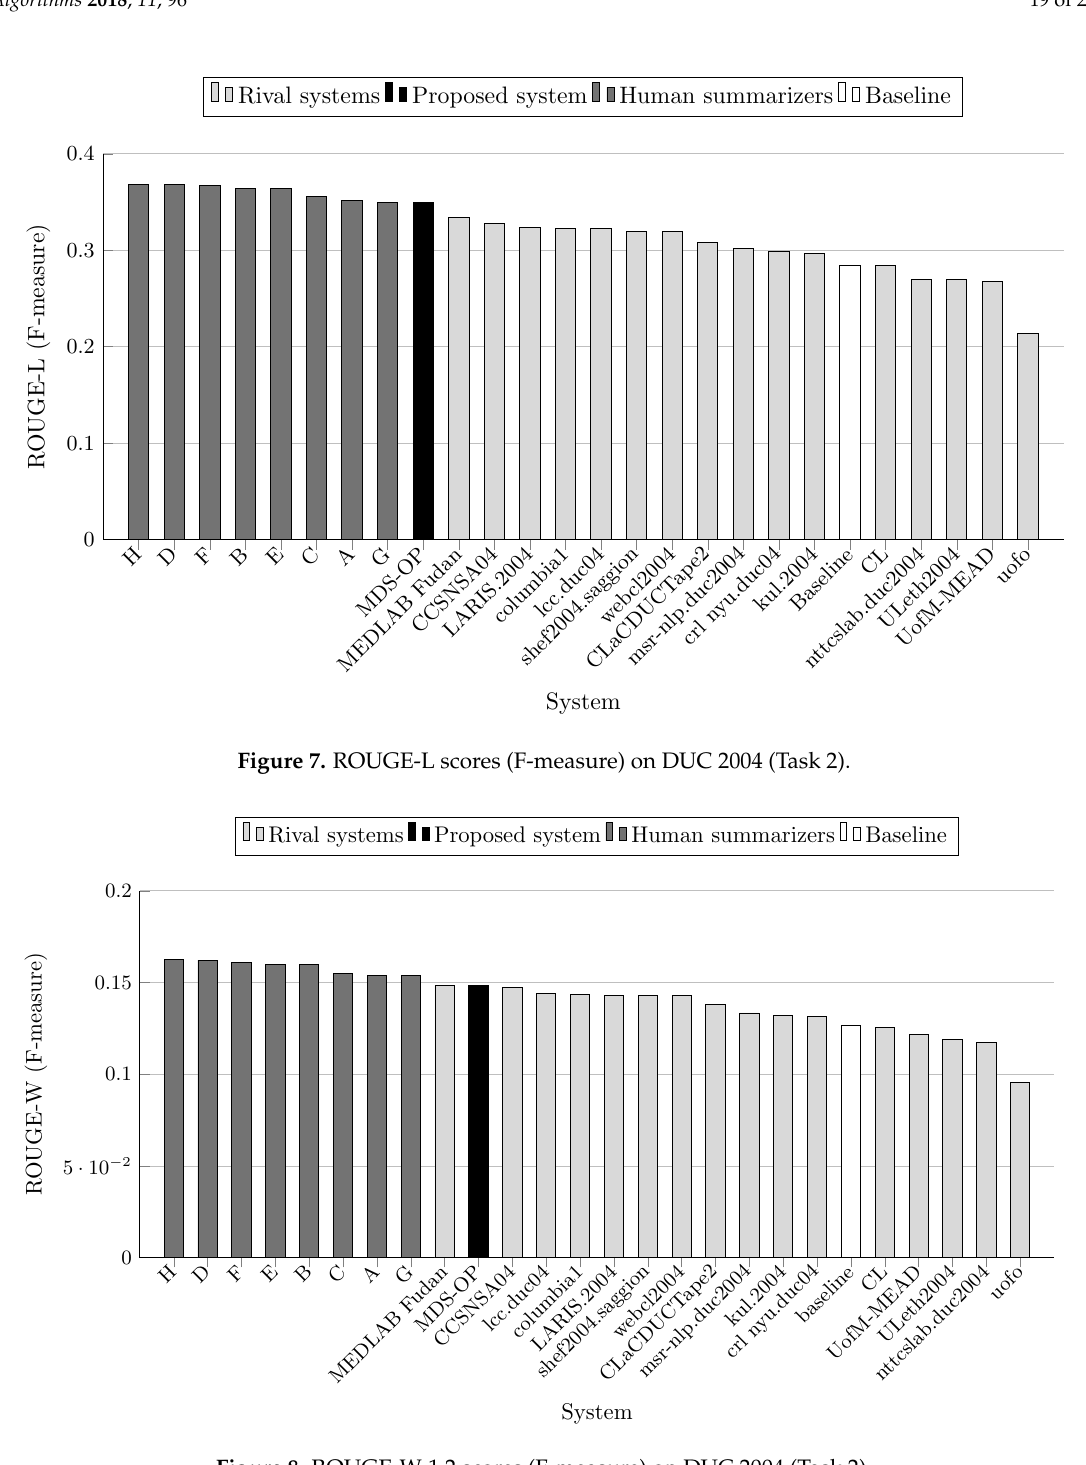
Figure 8. ROUGE-W-1.2 scores (F-measure) on DUC 2004 (Task